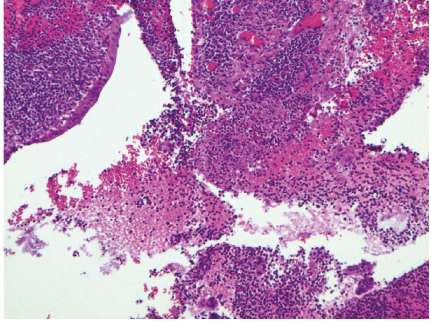
Figure 7: Appendix with focal mucosal hemorrhage.